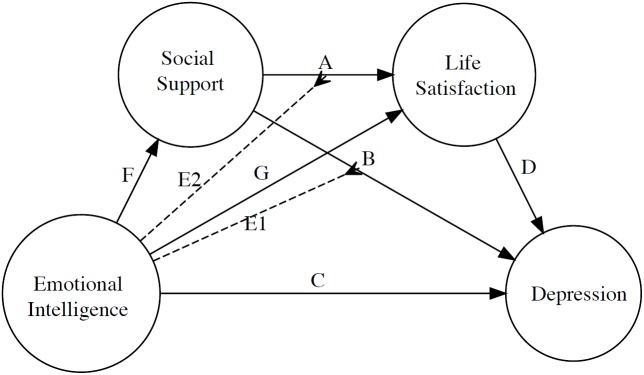
Hypothesized Model.